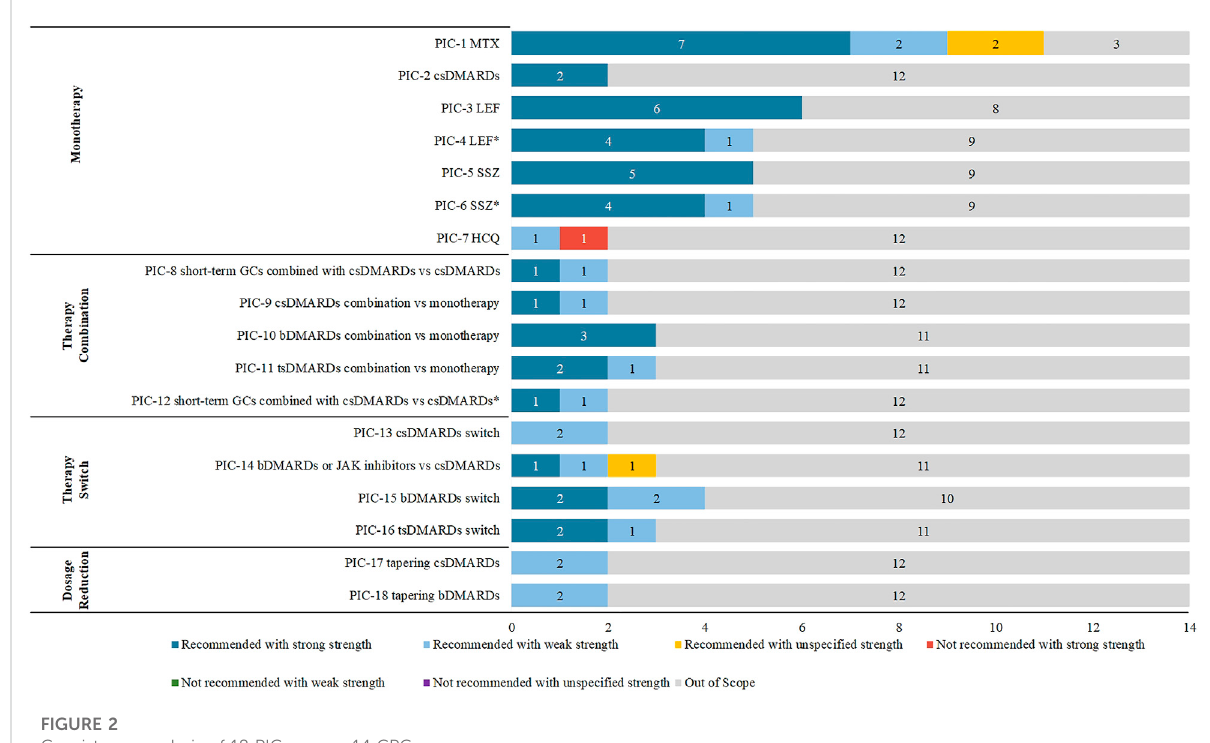
FIGURE 2 Consistency analysis of 18 PICs across 14